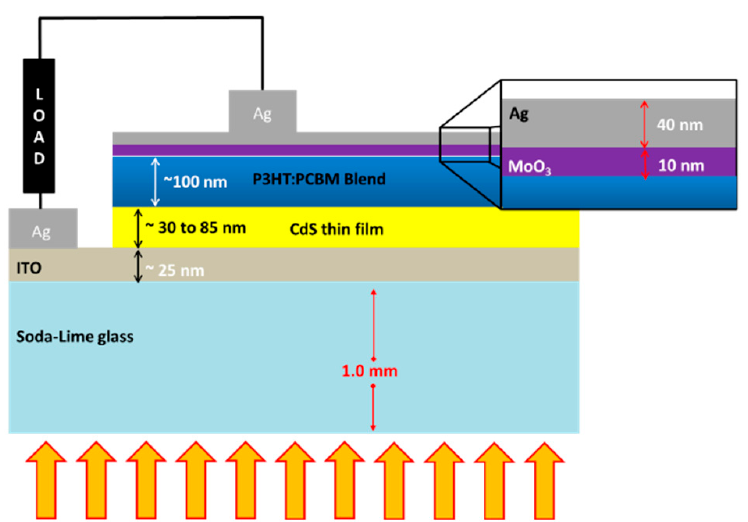
Figure 1. Schematic of the fabricated inverted device with an external load used for electrical measurements. The arrow marks indicate the shining of the light. (Not drawn to scale).